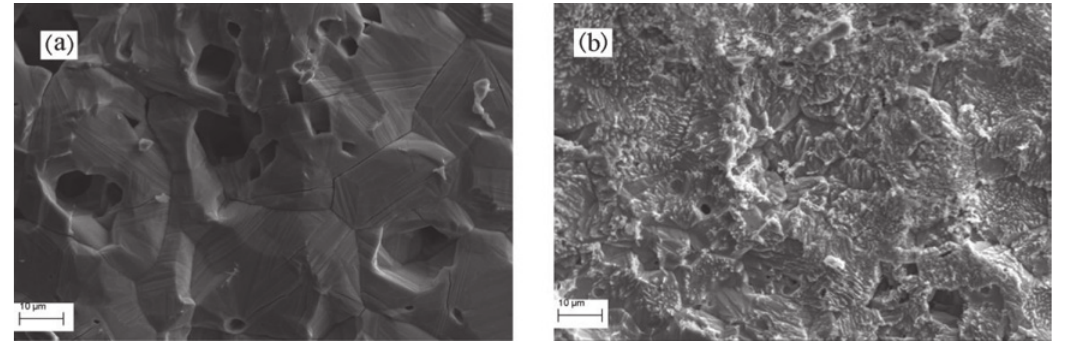
Fig. 9: The SEM micrographs of the Fe-16Cr alloy oxide scale at 1000 °C for 24 h: (a) the internal interface of the scale in H 2 O-air (0.001 μL liquid water pumped into 100 ml air, (b) the internal interface of the scale in air.